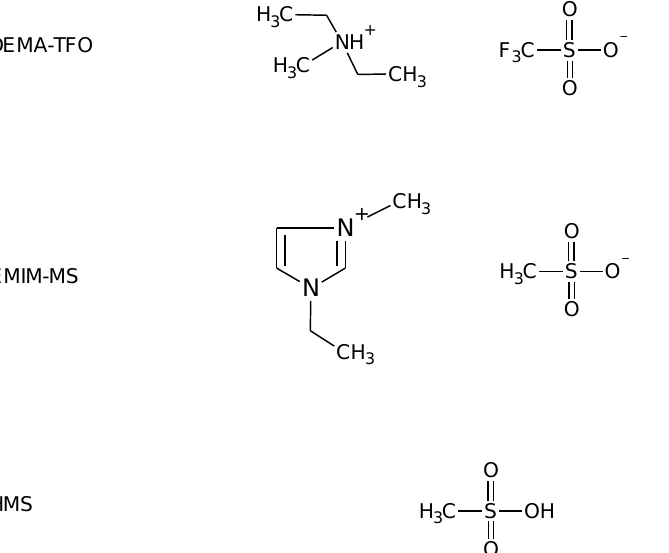
Figure 1. Structures of diethylmethylammonium triflate (DEMA-TFO), 1-ethyl-3-methylimidazolium methanesulfonate (EMIm-MS), and methanesulfonic acid (HMS) used in this study.